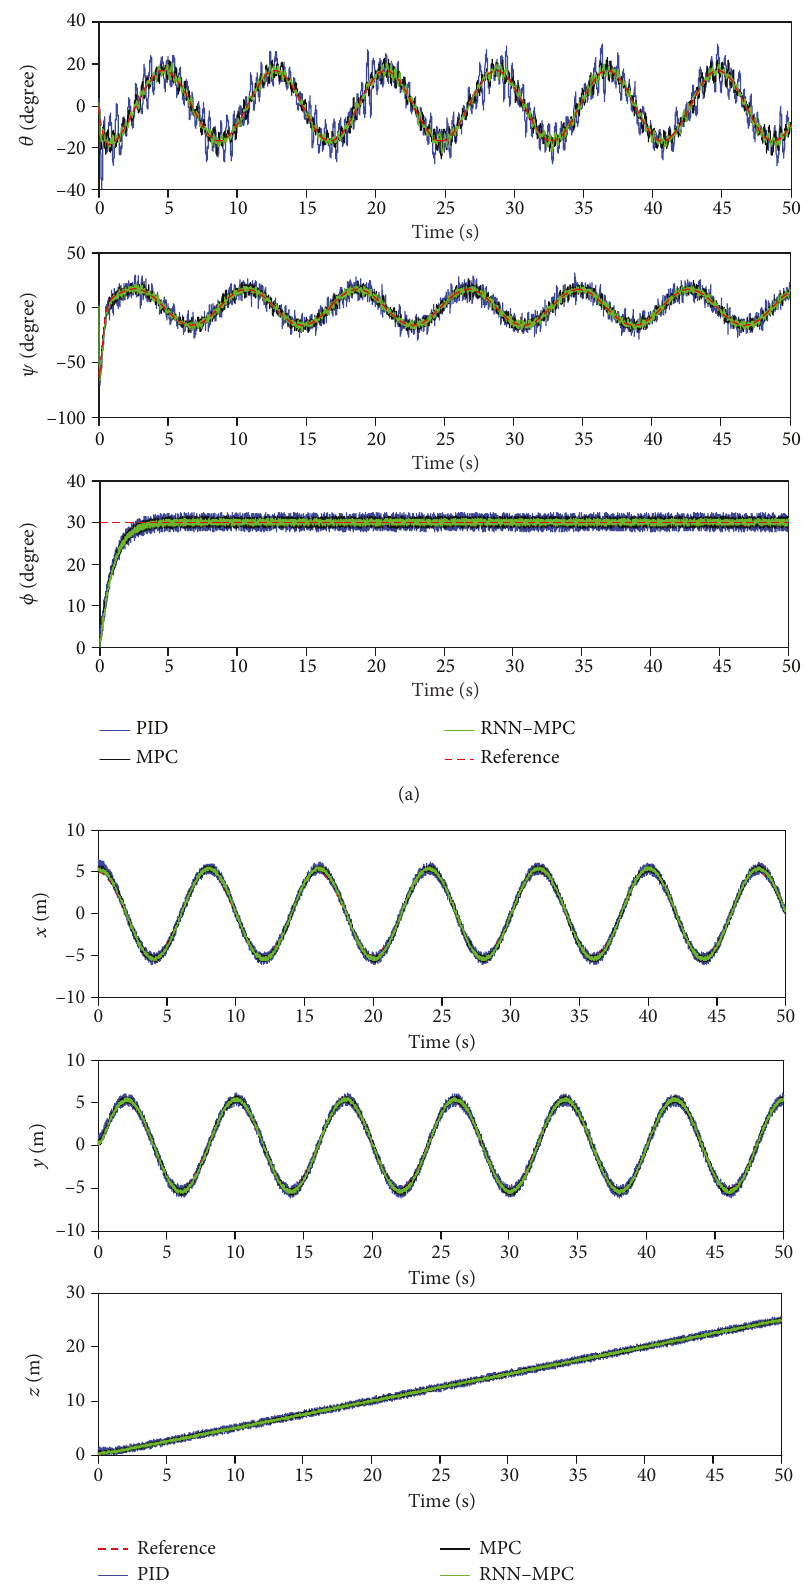
Figure 11: Comparison results: (a) the variation of attitudes; (b) the variation of